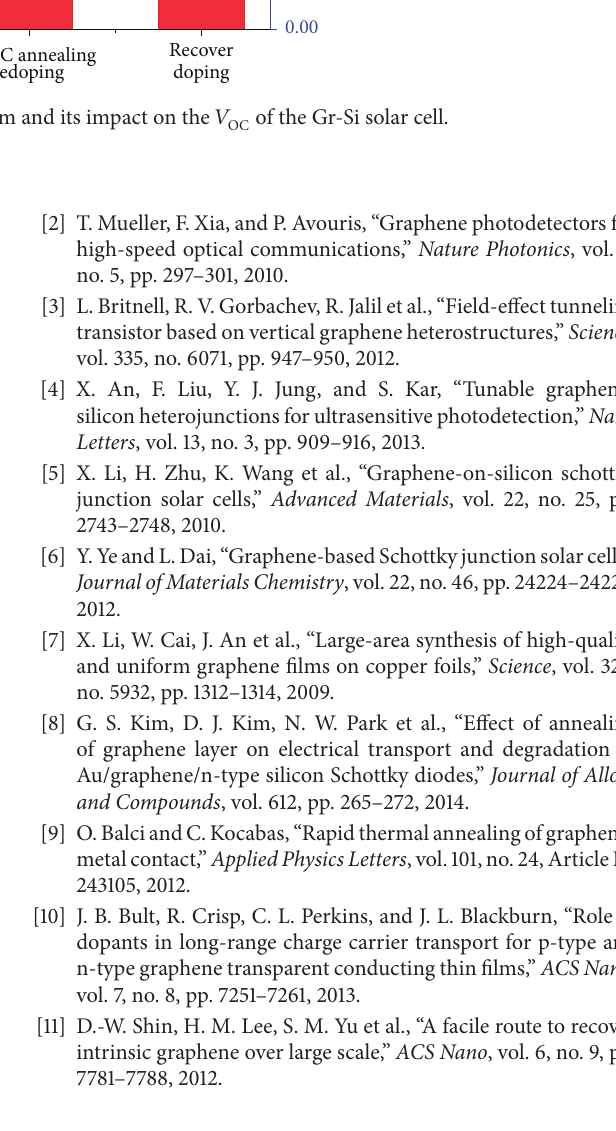
Figure 8: The nature doping effect of the Gr film and its impact on the 𝑉